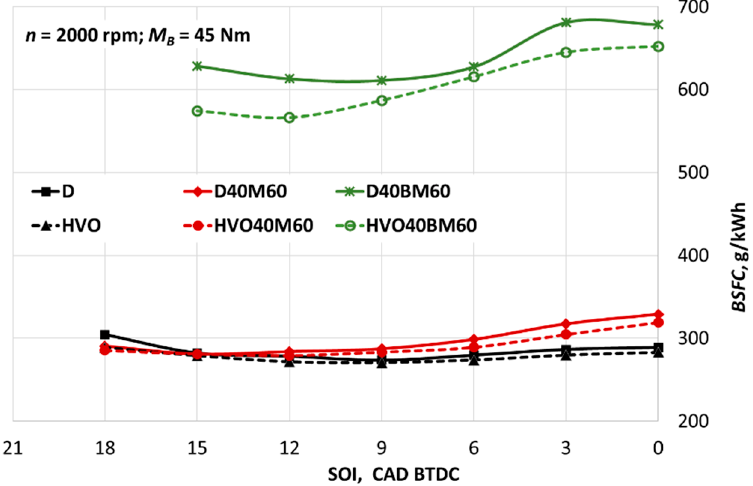
Figure 3. Change of the brake specific fuel consumption depending on fuel composition and start of injection (SOI).